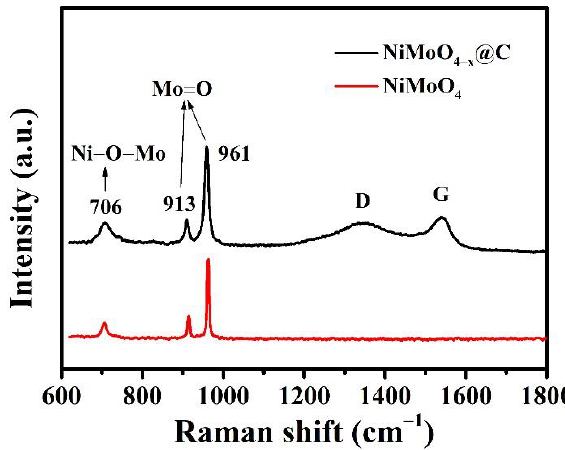
Figure 3. Raman spectra of NiMoO 4− x @C (black) and pristine NiMoO 4 NWAs (red) samples.